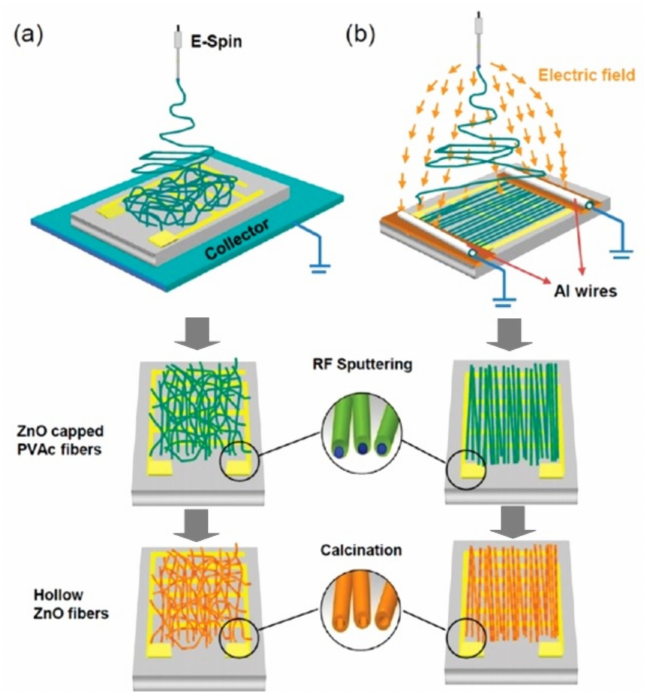
Figure 35. Schematic diagram illustrating the fabrication procedure of an array of ( a ) nonaligned and ( b ) quasi-aligned hollow ZnO fibers. Reprinted with permission from [138]. Copyright 2009